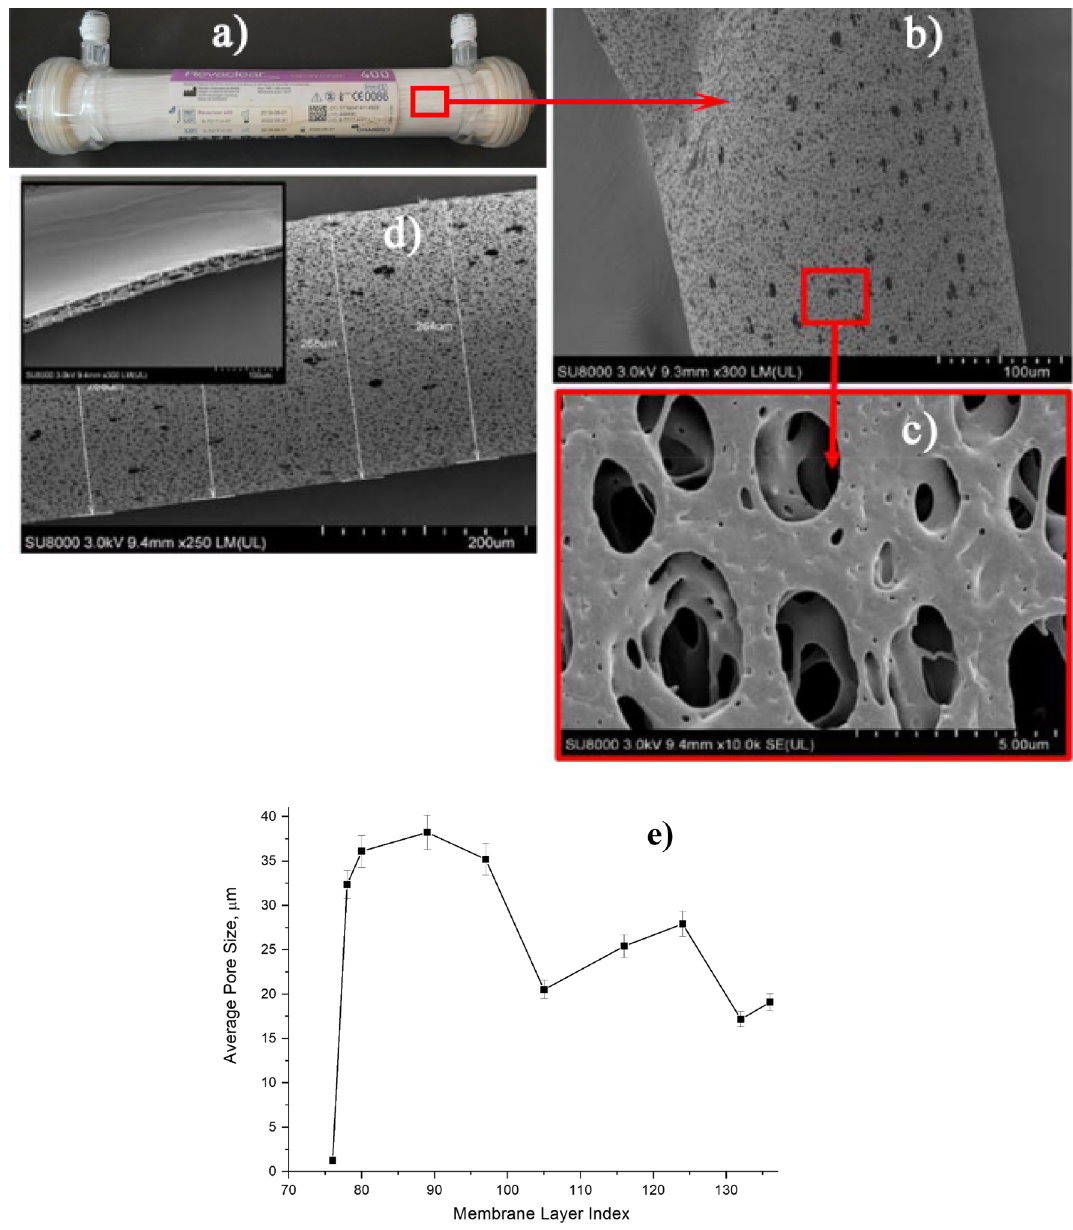
Figure 3. ( a ) PES hollow-fiber based membrane module; ( b – d ) SEM images of PES hollow fibers; and ( e ) average pore size of PES sheet membrane across thickness, using